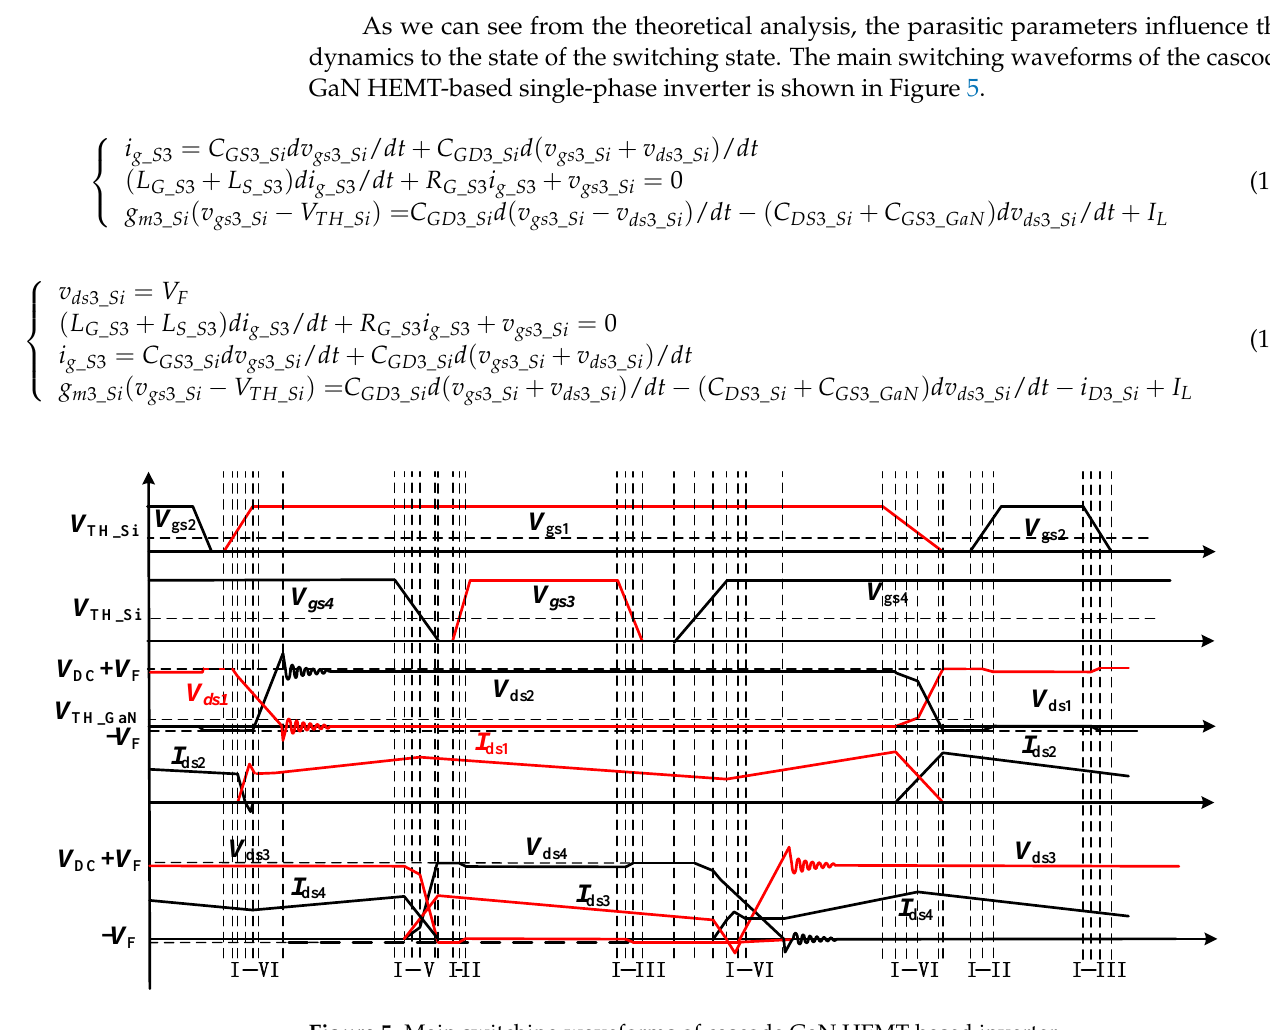
Figure 5. Main switching waveforms of cascode GaN HEMT-based inverter.